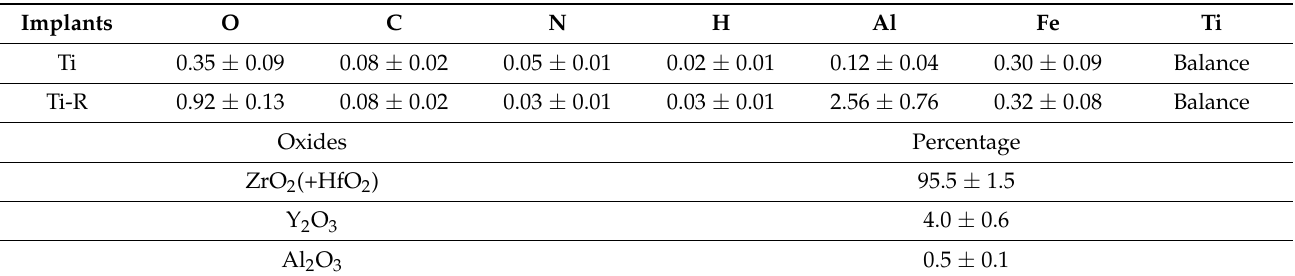
Figure 3. Scanning electron microscopy images of the surfaces of the different dental implants. ( a ) Ti, ( b ) Ti-R, and ( c ) ZrO 2 . Table 1. Dental chemical composition. Percentages in weight.